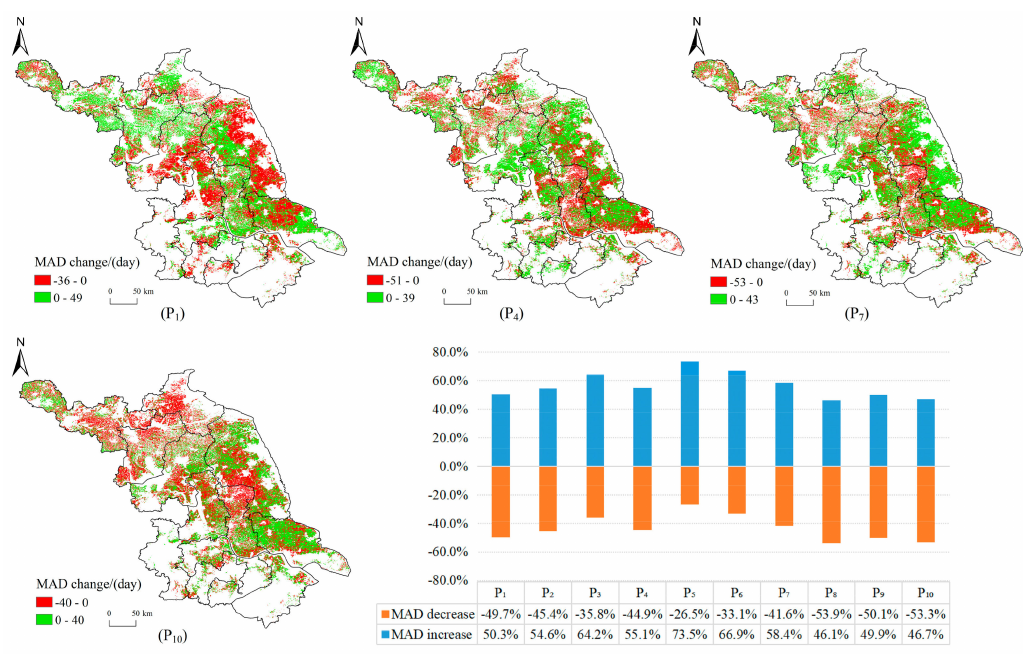
Figure 8. Changes and statistical results of the first crop MAD during a double season. Partial results (P 1 , P 4 , P 7 , and P 10 ) are shown. The statistical chart shows that the proportion of cultivated land of the first crop MAD changed from P 1 to P 10 . P 1 : T 2 -T 1 ; P 2 : T 3 -T 2 ; ... ; P 10 : T 11 –T 10